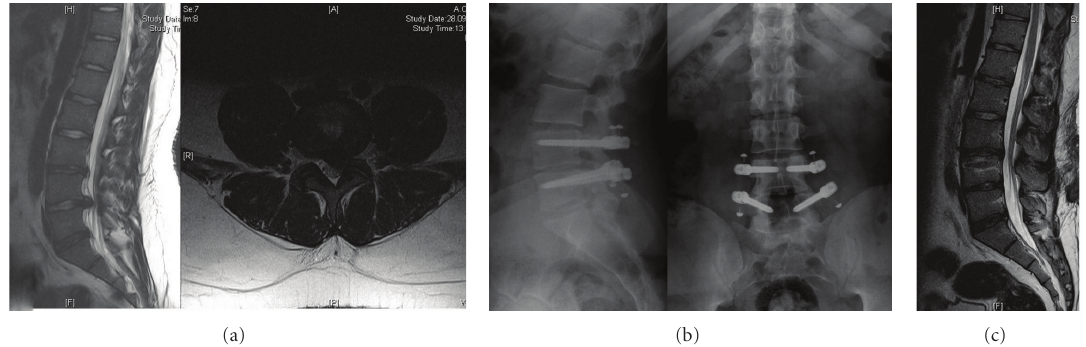
Figure 7: 20-year-old male patient with left leg pain and back pain. (a) T2 weighted MRI scans show L4-5 disc herniation; (b) PEEK rod was applied; (c) the patient was in very good condition, and T2 weighted MRI scan showed a nearly normal appearance after one year.